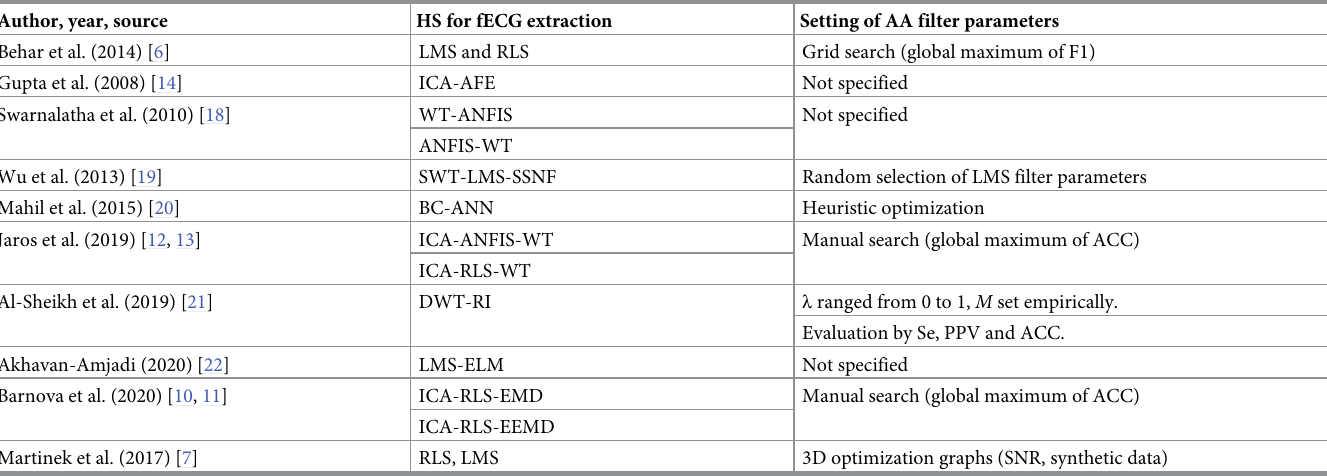
Table 1. Summary of state-of-the-art literature in adaptive fetal extraction systems and their optimization. Author, year,